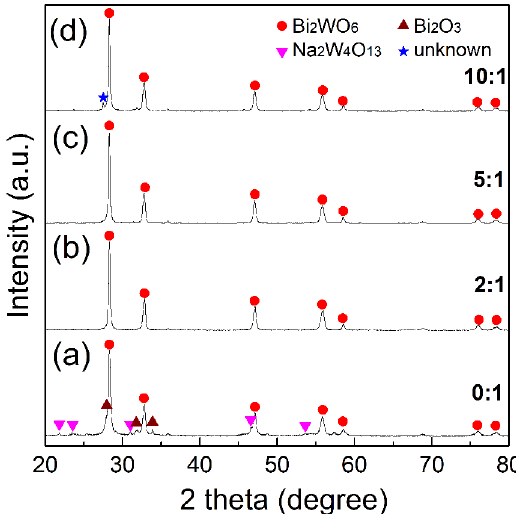
Figure 2. XRD patterns of samples synthesized at 350 ºC with different mass ratio of the salt and the precursor. The morphologies of the synthesized pure Bi